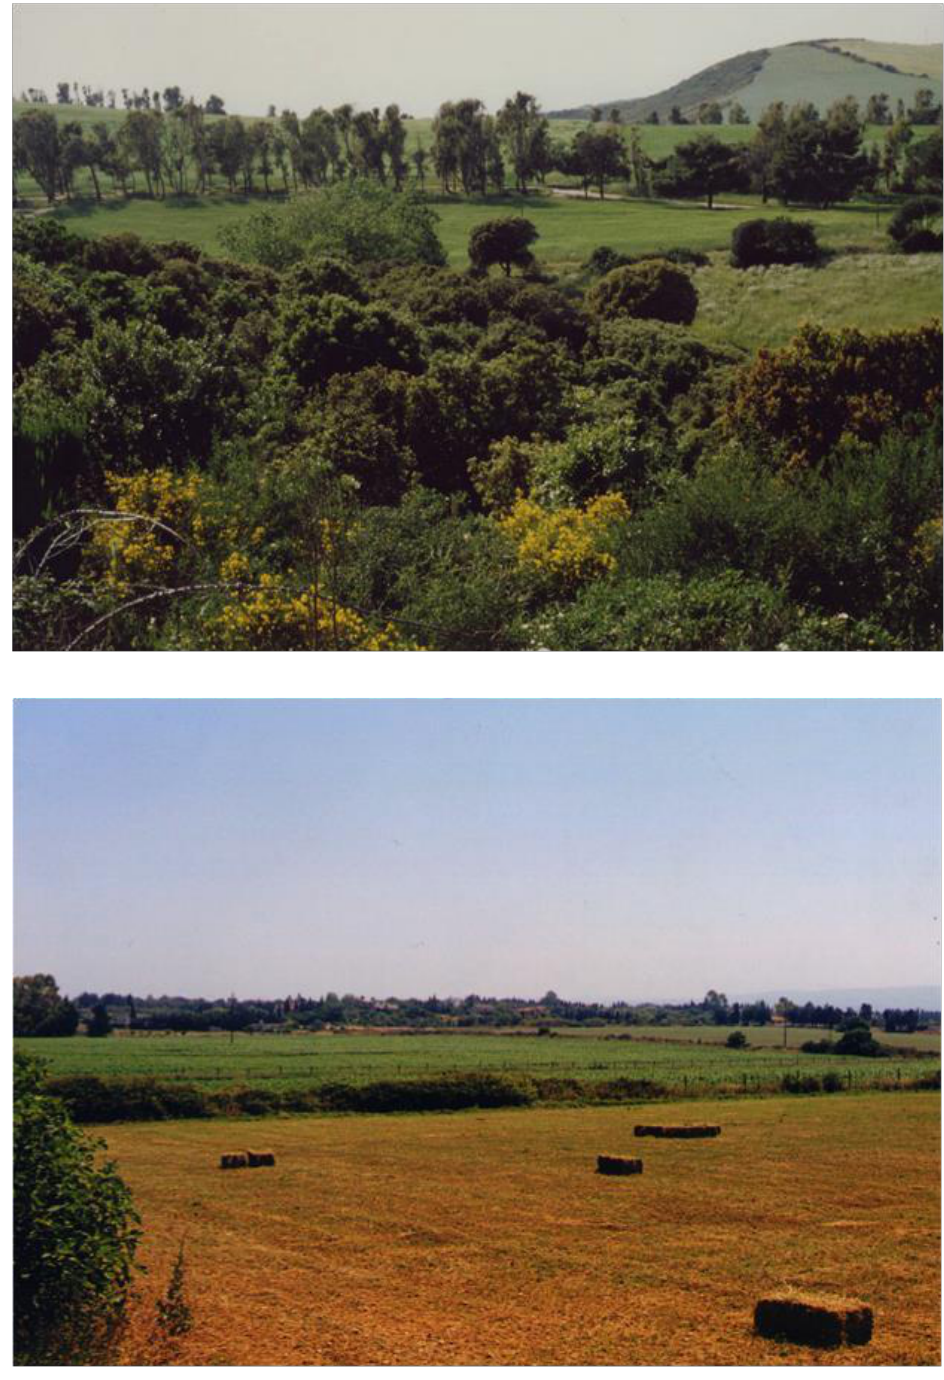
Figure 3. Two study habitats representative of northern Sardinia: a typical semi-natural farming area (Palmadula, SS; above) and a semi-intensive farming system (Ottava, SS; below).